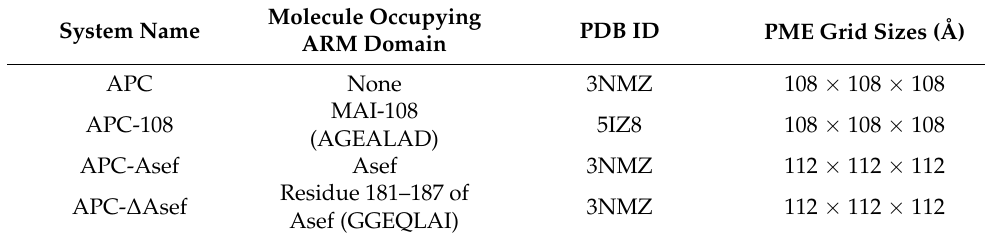
Table 3. Summary of the MD simulation